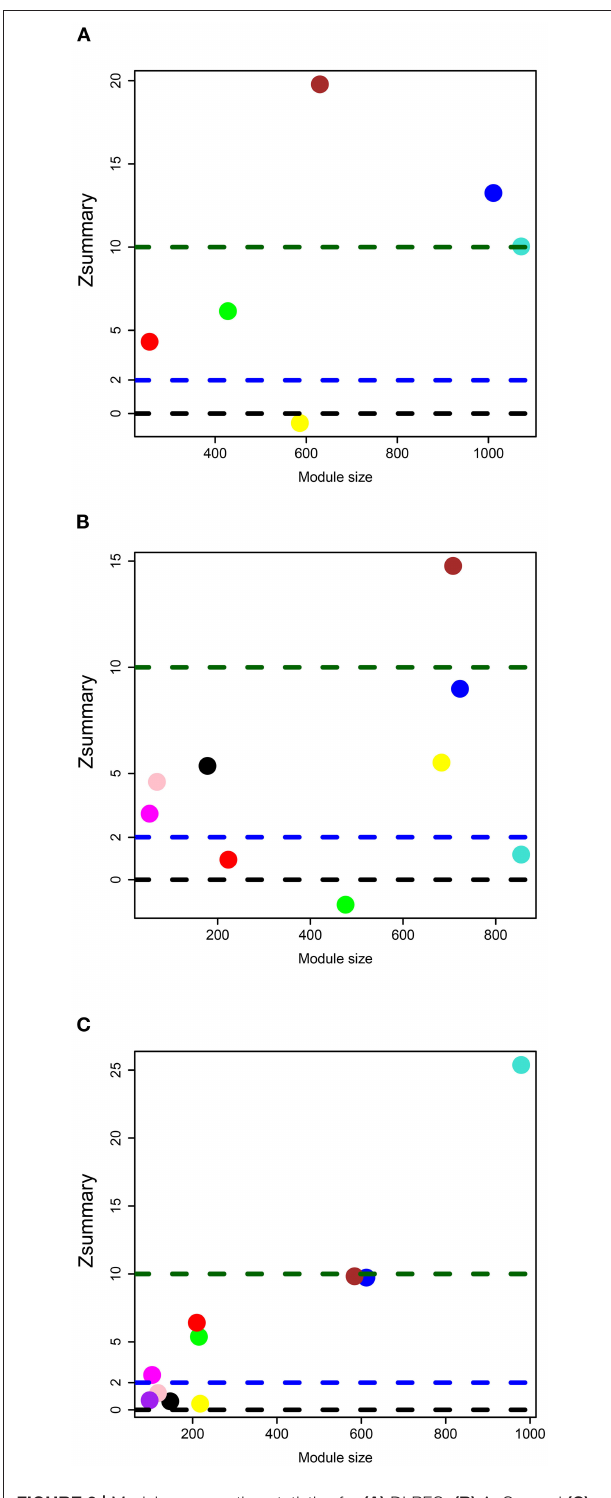
FIGURE 3 | Module preservation statistics for (A) DLPFC, (B) AnCg, and (C) nAcc data sets. The y-axis represents Zsummary , and the x-axis represents the number of genes in each module. Each circle represents a different gene module in brain tissue, and the modules above the blue dotted line represent that it is preserved in